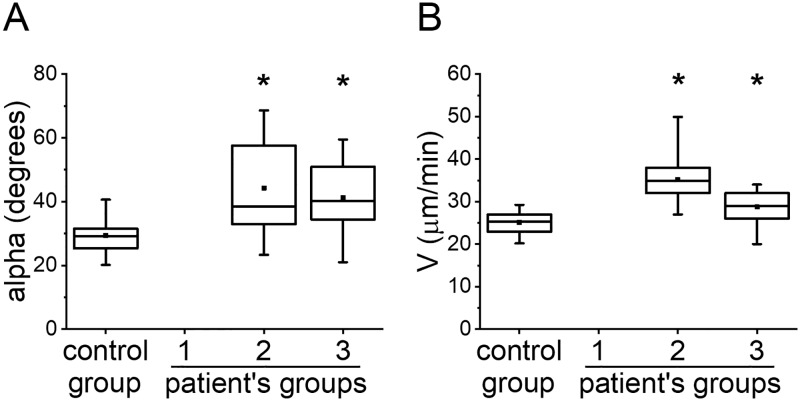
TEG vs TD before heparin treatment.(A) alpha in TEG and (B) V in TD before heparin treatment in groups: healthy volunteers (control group), group 2 and group 3. The box plots indicate the following parameters: the mean value (the dot inside the box), the median (the horizontal line inside the box), the 25th and 75th percentiles (the bottom and top of the box, respectively) and the 5th and 95th percentiles (the ends of the whiskers). * indicates a significant difference from healthy volunteers group (p<0.01, Mann-Whitney test).